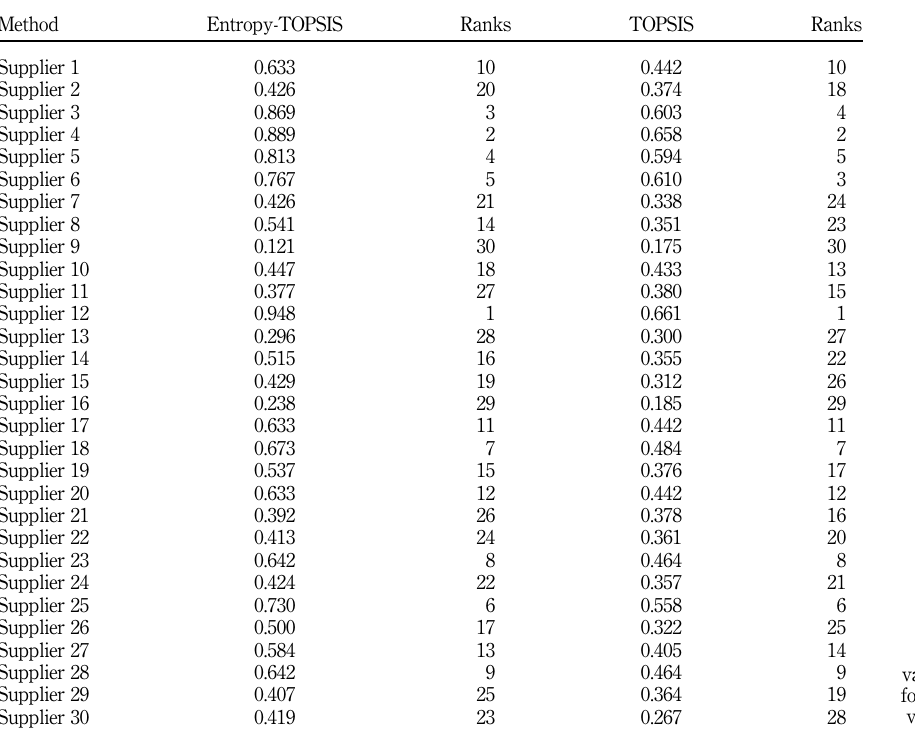
Table IX. Relative closeness values for suppliers for